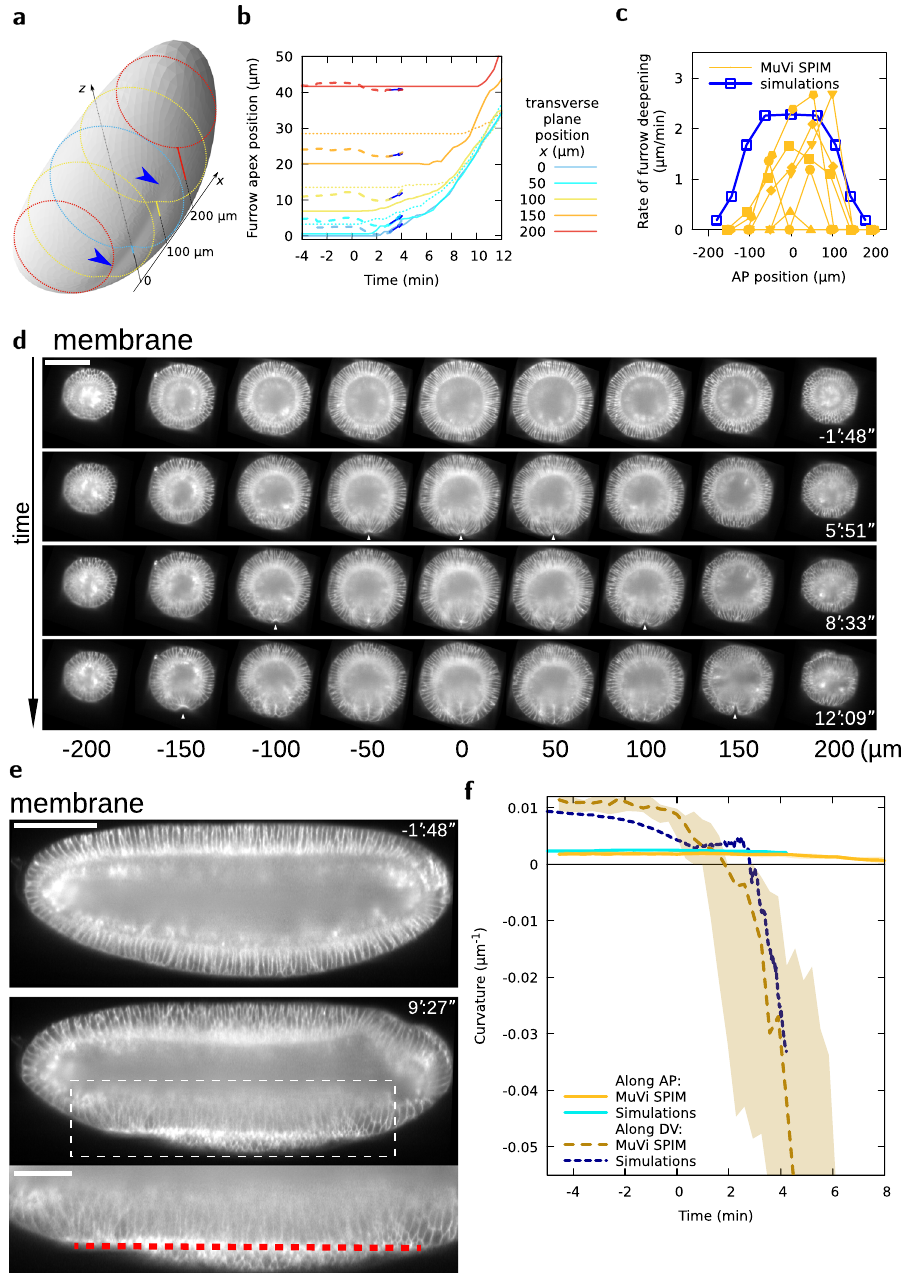
Fig. 4 VFF results from tissue curvature changes along the DV and AP axes. a Embryo shape during VFF in simulations at t ¼ 4 0 12 00 . Shading reveals furrow shape, blue arrowheads. Dotted lines are transverse cuts, solid lines give the furrow apex offset from a reference z position at different x positions. b Furrow apex position at different AP positions as a function of time in MuVi SPIM experiments (solid lines, posterior side, dotted lines, anterior side, n = 6) and simulations (dashed lines and arrow showing slope at t ¼ 3 0 ). c Rate of furrow formation at different AP positions at t ¼ 3 0 . d Digital cross- sections at different AP positions. White arrowheads indicate VFF initiation. Scale bar 100 μ m. e Digital mid-sagittal section of the embryo. Red line indicates ventral tissue fl attening. Scale bars 100 μ m, zoom 50 μ m. f Curvature of the ventral tissue along the AP and DV axes as a function of time (MuVi SPIM, n = 6 embryos, shaded area denotes minimum and